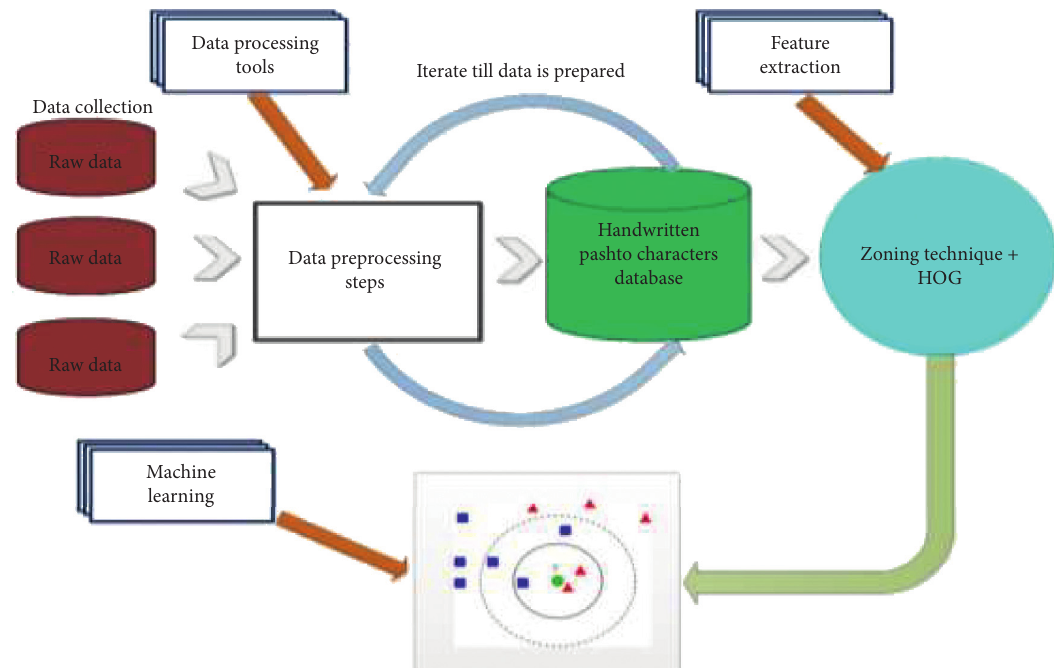
Figure 1: Proposed methodology flow diagram.